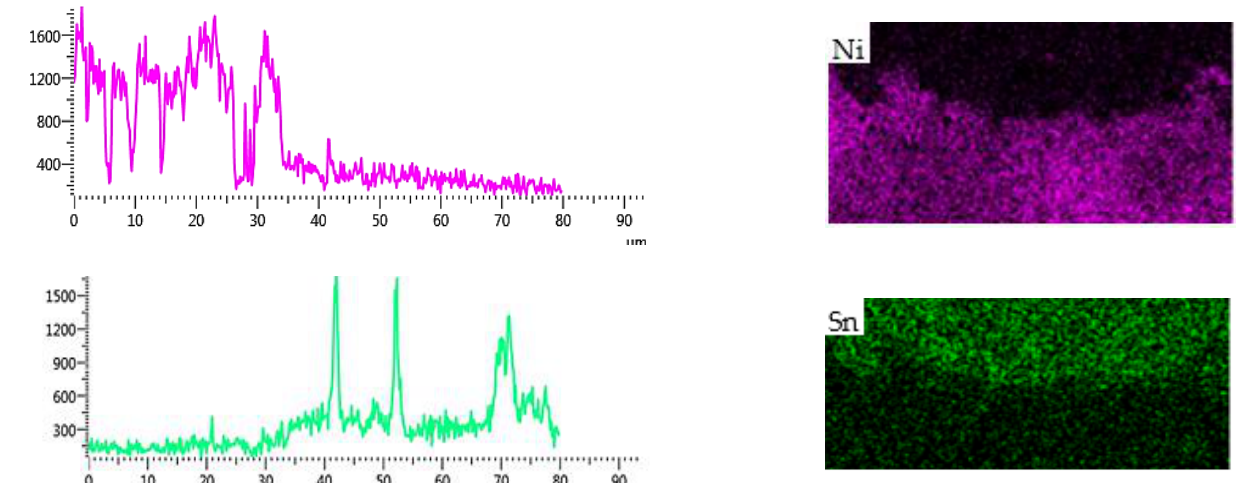
Figure 6. Element distribution in the interface between CuSn15 and Inconel 718 obtained by EDS.